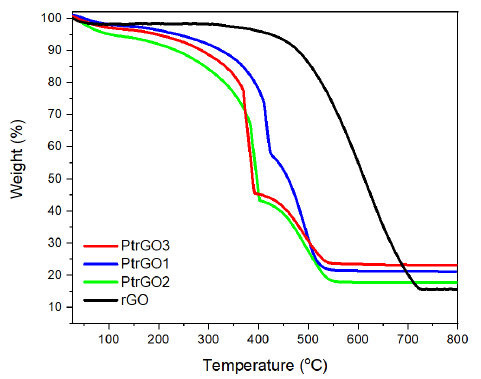
Figure 4. Thermogravimetric analysis of the samples of the rGO-supporting matrix with respect to the PtrGO1, PtrGO2 and PtrGO3 samples.